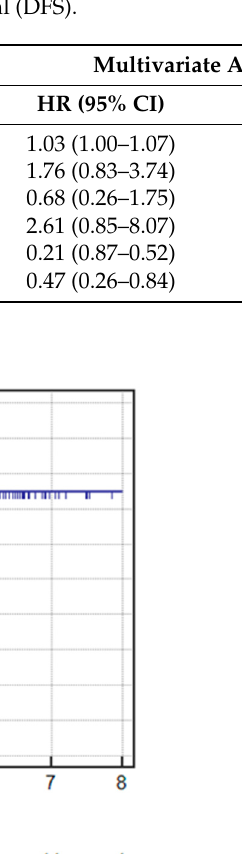
Table 4. Cox regression analysis for disease-free survival (DFS).